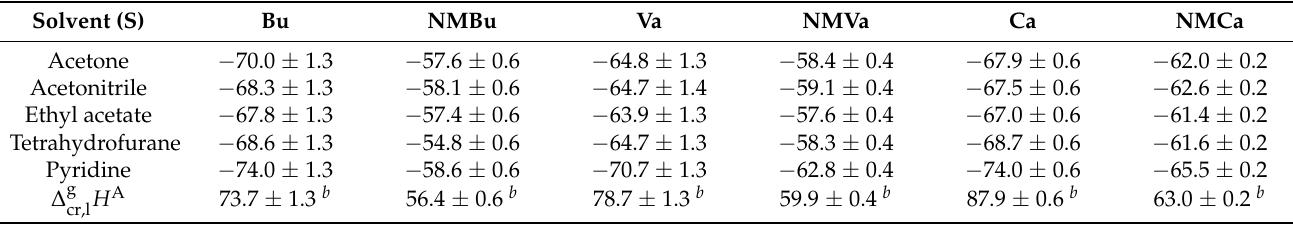
Table 2. Solvation enthalpies of γ -butyrolactam (Bu), N -methylbutyrolactam (NMBu), δ -valerolactam, (Va), N -methylvalerolactam (NMVa) and ε -caprolactam (Ca), N -methylcaprolactam (NMCa) in proton acceptor solvents, and evaporation enthalpies of cyclic amides (kJ · mol − 1 , T = 298.15 K , P = 0.1 MPa) a . Solvent (S)